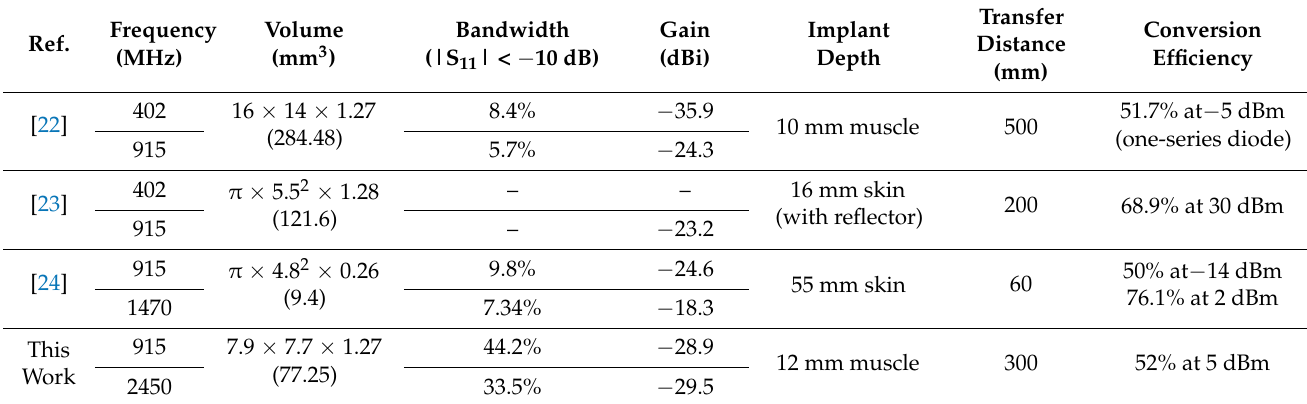
Table 3. Performance Comparison with Previous